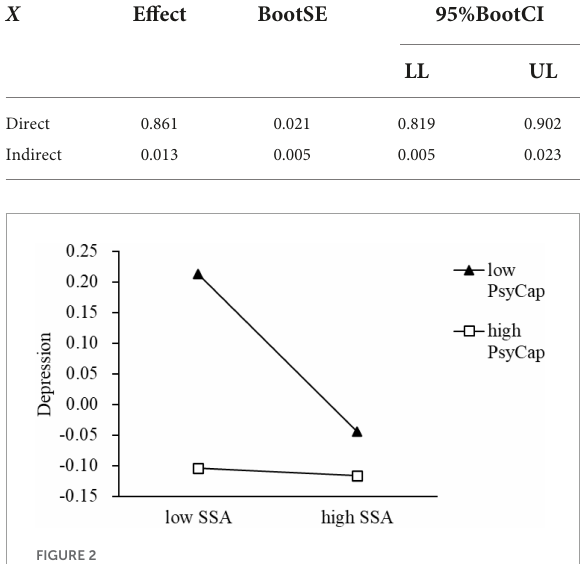
FIGURE2 The simple slope test of the moderating effect of PsyCap on the relationship between SSA and depression. SSA, social support availability; PsyCap, psychological capital.